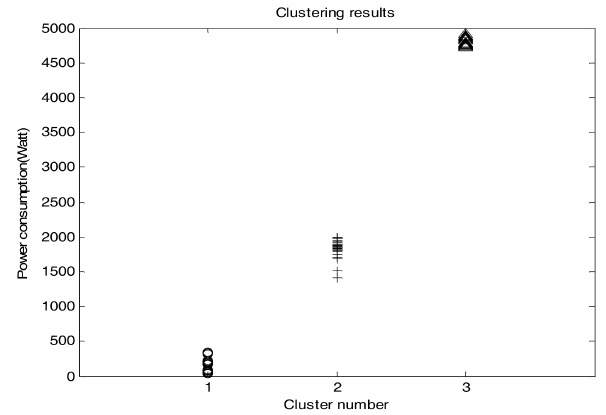
Figure 3. The example of clustering